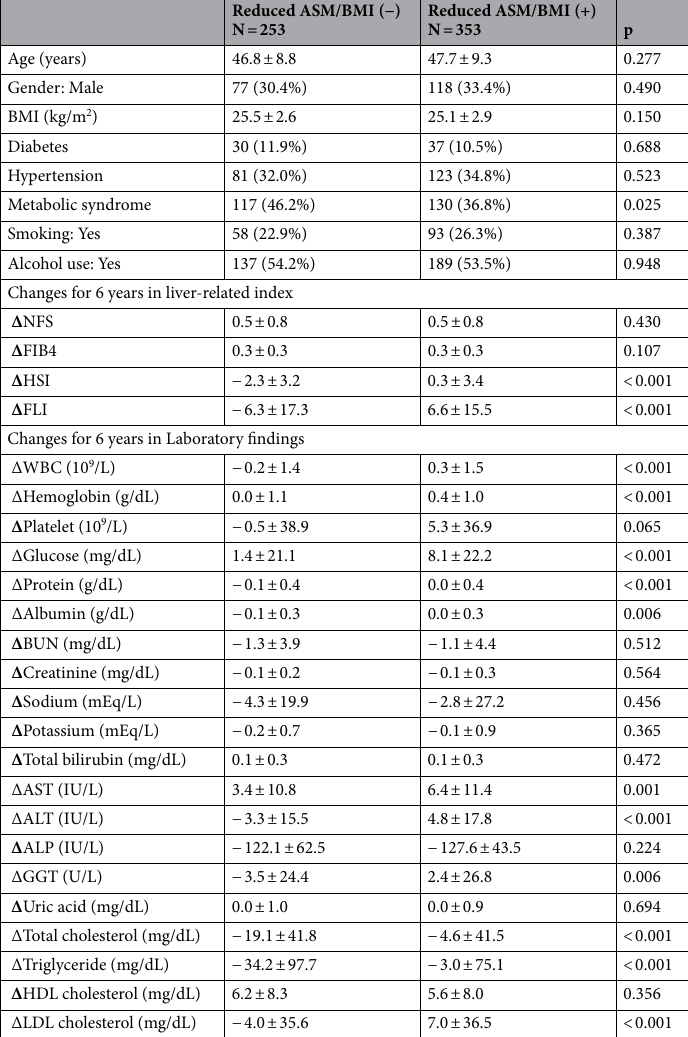
Table 3. Differences of two groups according to the muscle mass reduction, at the time of baseline visit and changes for 6 years (bold: p value < 0.05). ASM Appendicular skeletal muscle mass, BMI Body mass